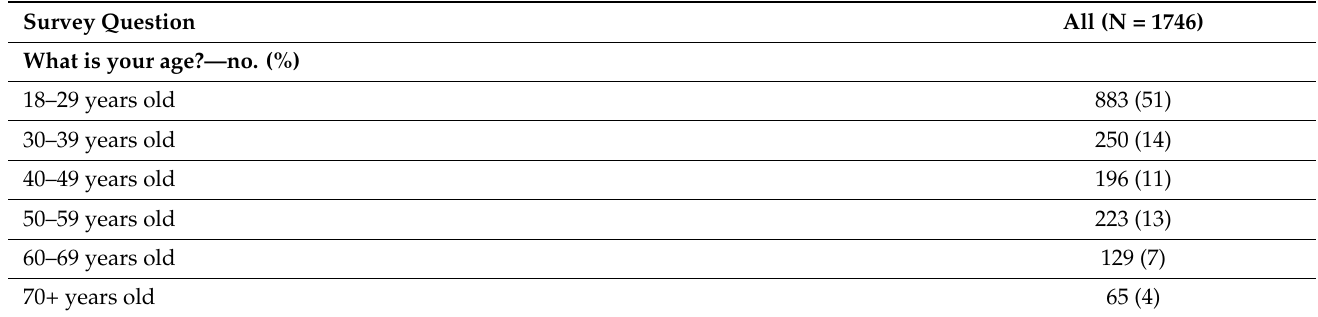
Table 1. Participant characteristics and beliefs and attitudes toward